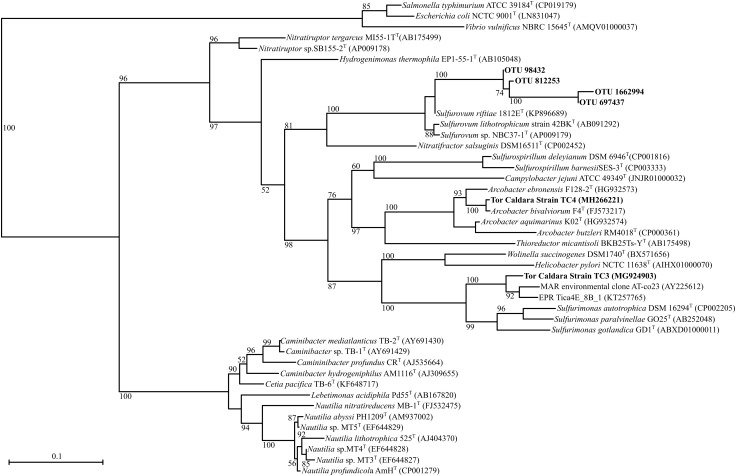
Maximum-likelihood phylogenetic tree derived from V4 regions and full length 16S rRNA gene sequences showing the position of OTUs classified as Sulfurovum within the Epsilonproteobacteria and strains TC3 and TC4. aLRT branch support values higher than 50% were based on 1000 replicates and are shown at each node. Bar, 0.1% substitutions per position. Sequences belonging to the class Gammaproteobacteria were used as outgroup.